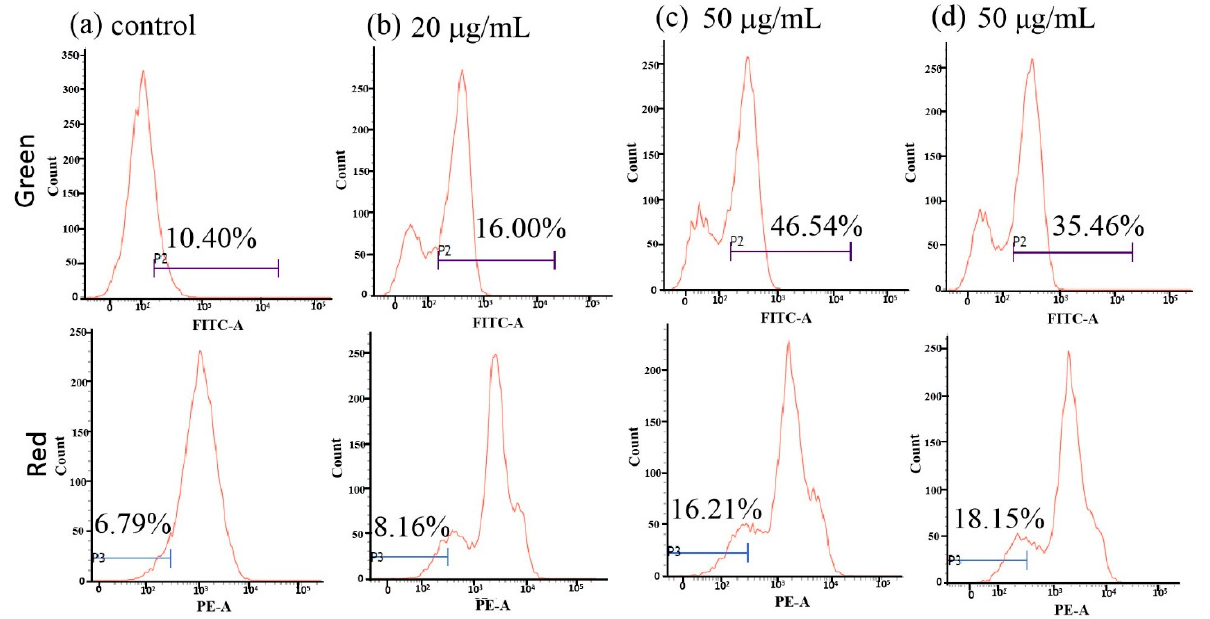
Figure 7. Flow cytometry of mitochondrial membrane potential (MMP) in HepG2 cells cultured with Au@MPA-PEG-HA- ADH-Dox. ( a ) Control; ( b ) 20 μ g/mL; ( c ) 50 μ g/mL; ( d ) 50 μ g/mL (Dox).